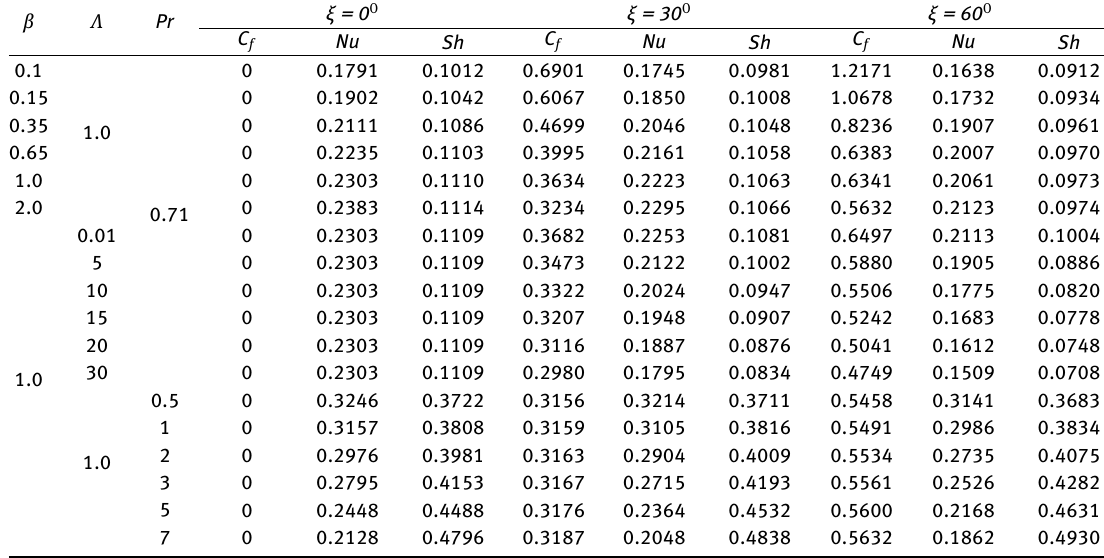
Table 2: Values of C f , Nu and Sh for various values of β , Pr , Sc and ξ ( Nb = Nt = 0.2, Nr = 0.1, Da = 1.0, M = 0.5, Le = 0.6)